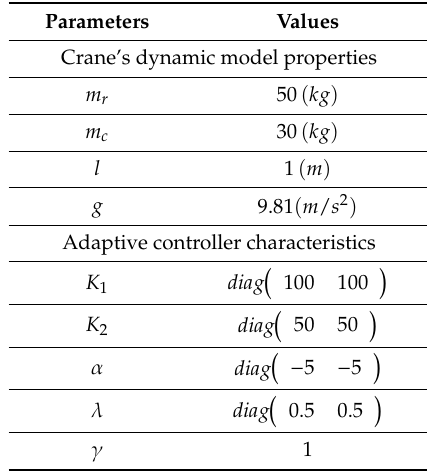
Table 1. The parameters of a 3D overhead crane and its controller